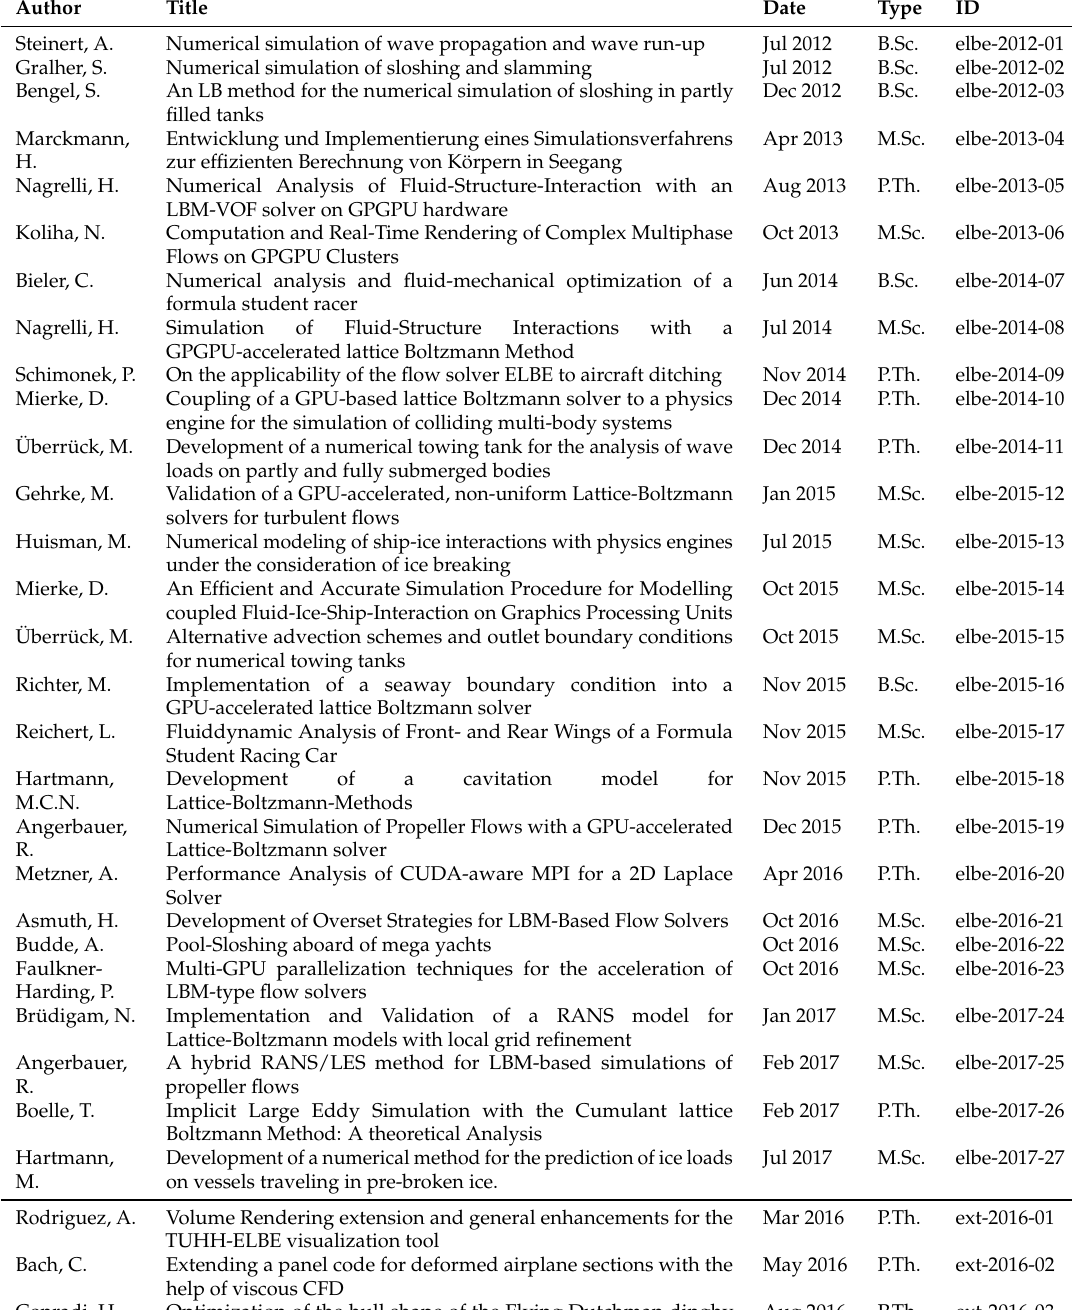
Table 3. List of completed ELBE thesis projects: bachelor theses (B.Sc.), master theses (M.Sc.) and project theses (P.Th.). Note that most of the titles were translated from German to English. An up-to-date list can also be found online: